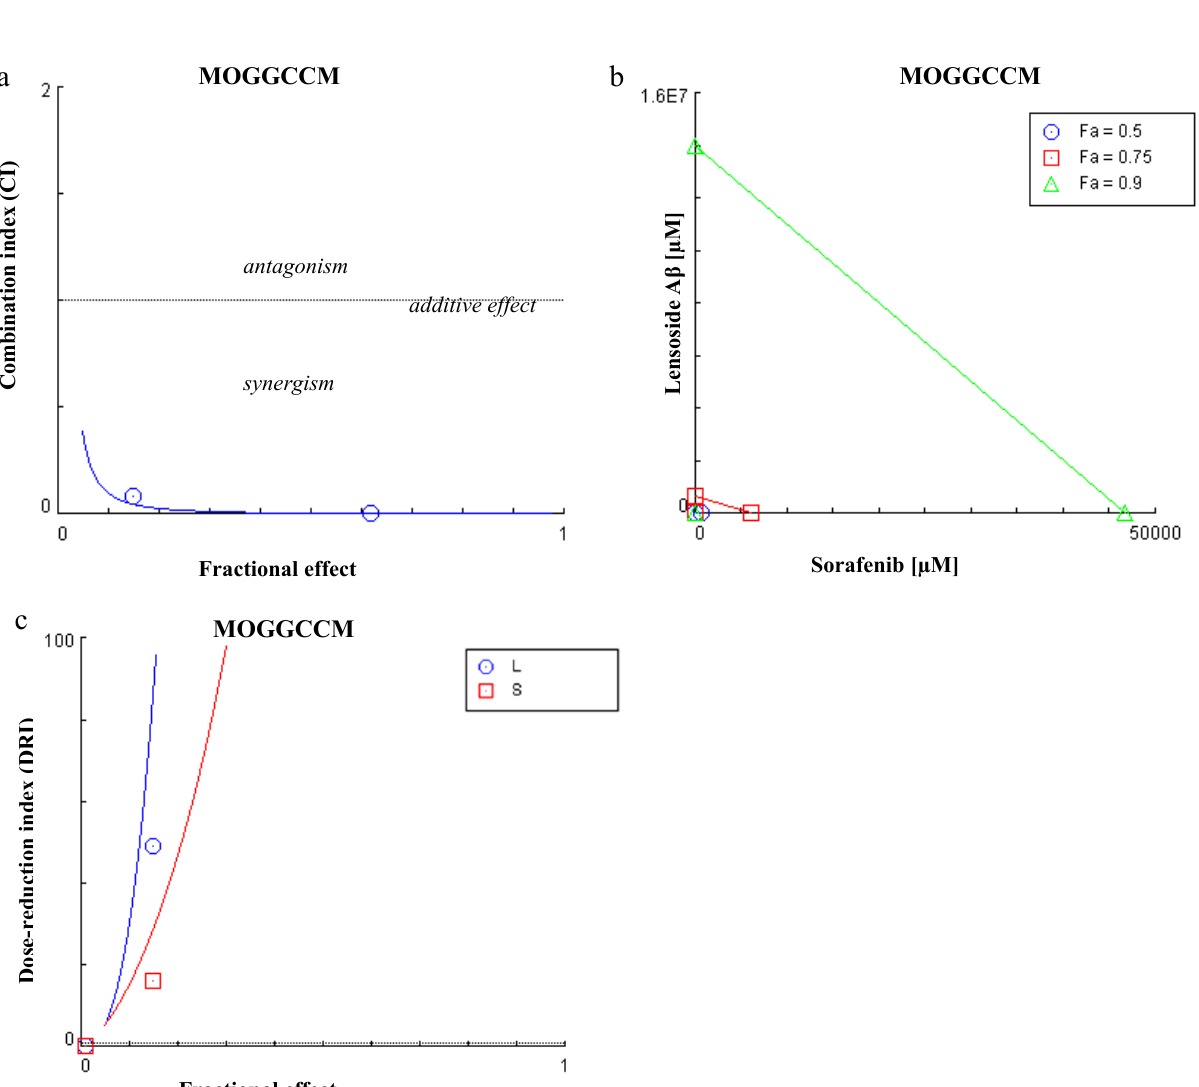
Figure A1. Lensoside A β (L) and sorafenib (S) combination treatment. ( a ) Combination index (CI) plot: The combination index is plotted as a function of Fa (fractional effect). ( b ) Isobologram for combination: isobologram at IC50, IC75, and IC90. ( c ) the Fa-DRI (dose reduction index) plot (Chou-Martin plot). Combination index (CI) and dose reduction index (DRI) were calculated according to the method of Chou and Talalay using the Compusyn software. CI < 1, CI = 1 and CI > 1 indicate synergistic effect, additive effect, and antagonistic effect, respectively. The combination of lensoside A β with sorafenib in the MOGGCCM line showed a synergistic effect. It was stronger when the higher dose was used, which is extremely important in anti-cancer therapy (for IC97, CI = 0.0001). Moreover, the combination treatment significantly reduced the doses of both drugs (DRI > 1), which in a single application would have to be higher to obtain the same effect. The final concentration of lensoside A β and sorafenib used in further studies was 50 µM and 1 µM, respectively.